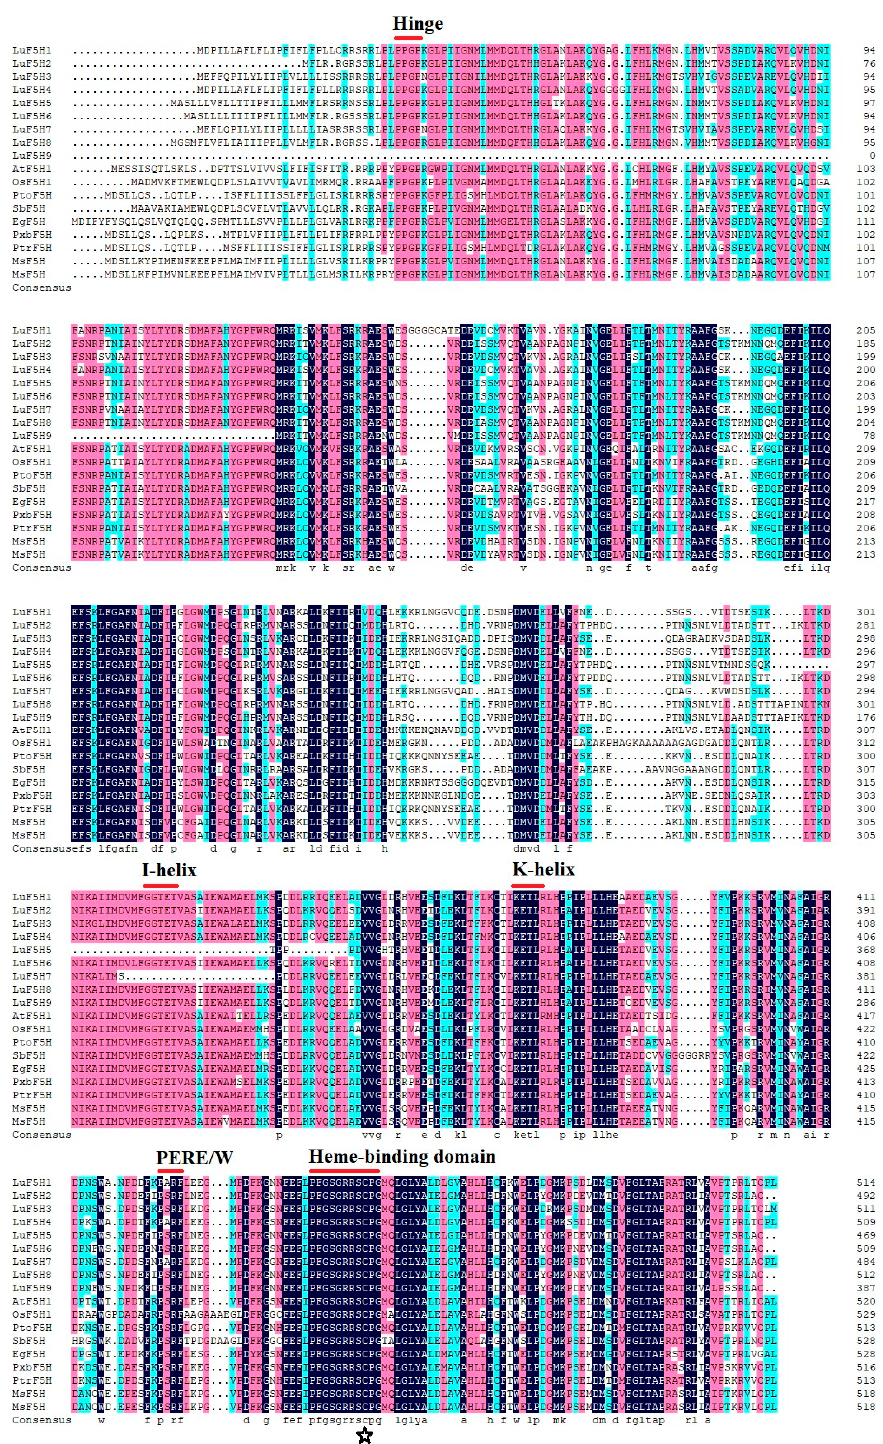
Figure 1. Multiple alignment of F5H amino acid sequences. The amino acids conserved in all the sequences are shaded in black. Sequence identity ≥ 75% is shown in pink, and sequence identity ≥ 50% is shown in blue. The signature motifs in P450 proteins, including the proline-rich membrane hinge, the AGxD/ET (I-helix), the KETRL (K-helix), the PERF/W and the heme-binding domain, are indicated by solid red bars. The black pentagram marks the cysteine residue important for heme binding. Details of the F5H sequences are shown in Table